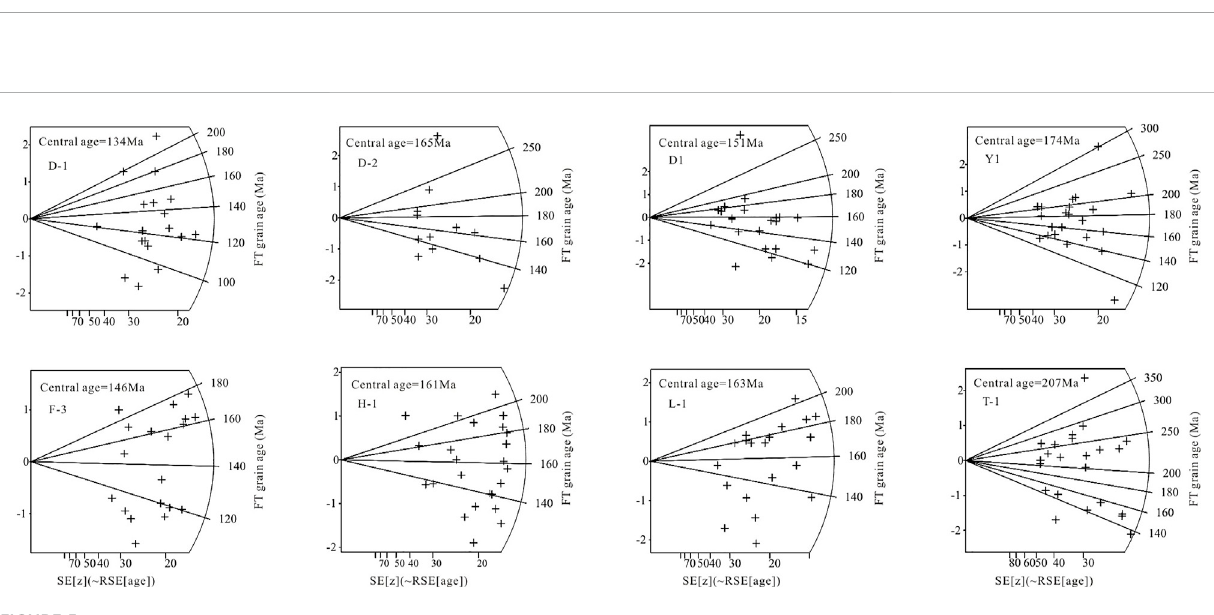
Zircon FT dating The ZFT dating results are shown in Table 3 and Figure 5. Six samples showed P ( χ 2 ) > 5%, indicating that the grains belong to the same group. The D-2 and D1 samples showed P ( χ 2 ) < 5%, indicating